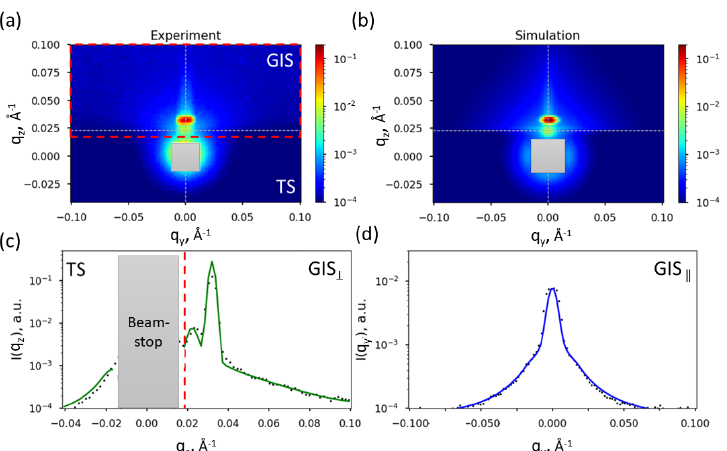
Figure 2. Experimental ( a ) and simulated with BornAgain ( b ) 2D grazing incidence small-angle neutron scattering (GISANS) scattering pattern of adsorbed p(MEO2MA-co-OEGMA) microgels. White dashed lines in ( a , b ) correspond to the cuts depicted in ( c , d ). In ( c , d ) the perpendicular (along q x ) and the parallel (along q y ) to the sample surface cuts are presented, dots and solid lines in ( c , d ) correspond to experimental and simulated data, respectively. Grey masks in ( a – c ) is beam-stop that blocks direct beam. The red dashed line in ( c ) represents the sample